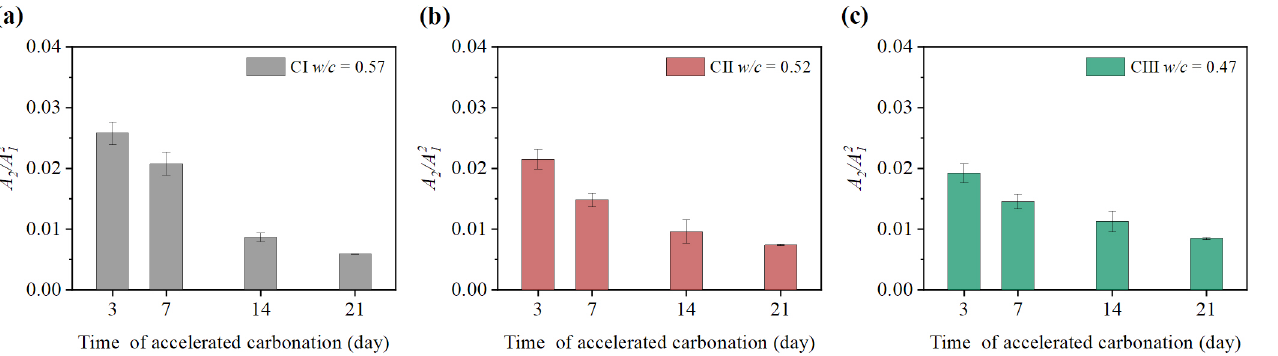
at 0 ◦ C: ( a ) nonlinear parameter A 2 / A 2 1 of CIII. 1